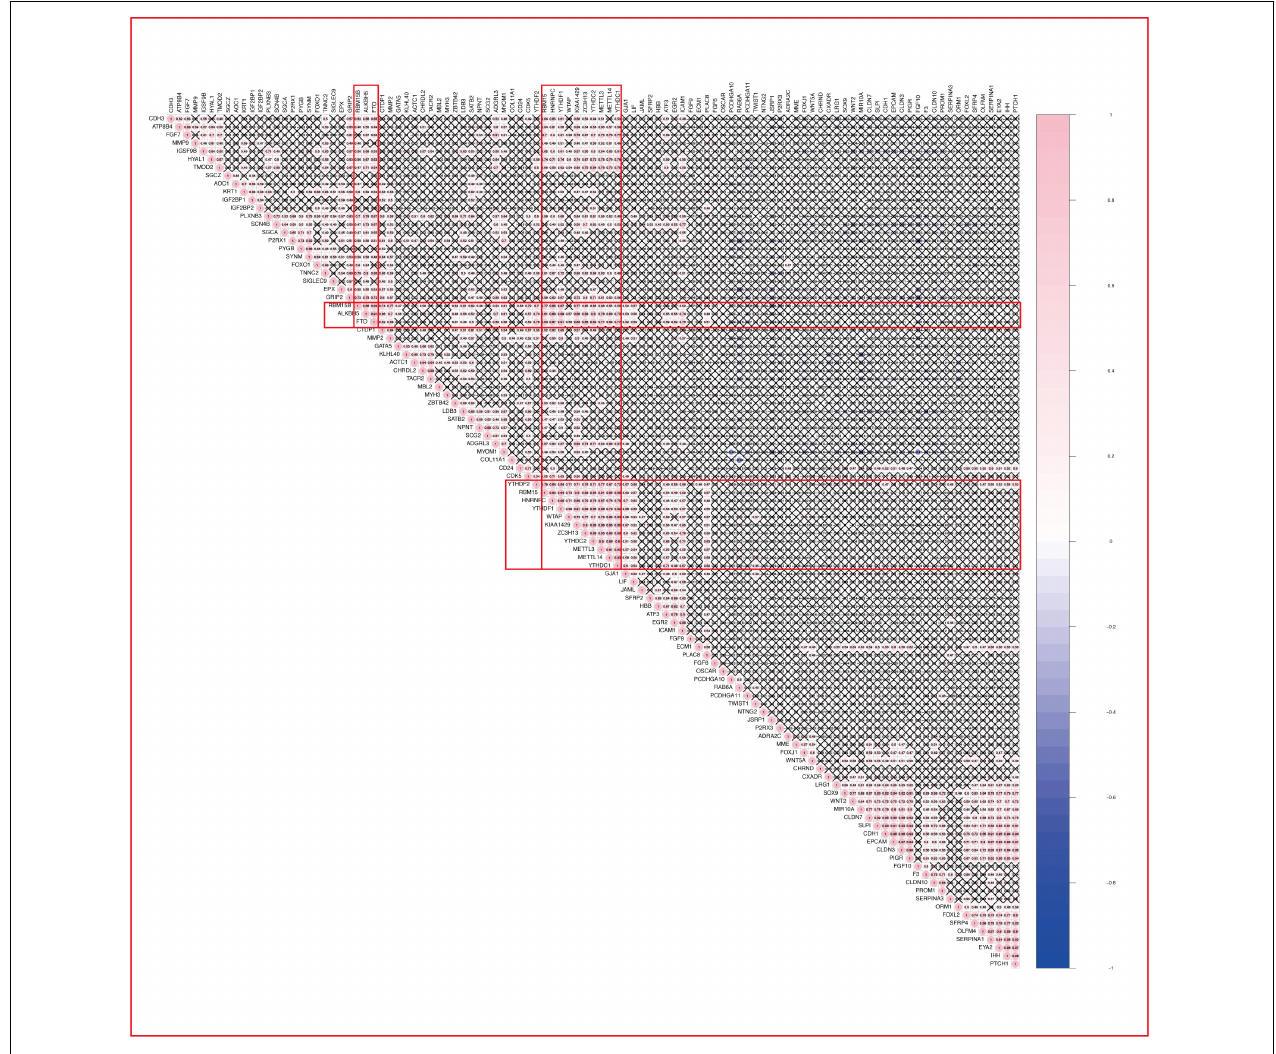
FIGURE 6 | The Spearman correlation between m 6 A RNA methylation regulators and the DEGs of myometrium enriched in the GO terms that related to myometrium dysfunction of adenomyosis patients. “X” p > 0.001, Red line clarified that correlation between the 13 m 6 A regulation “cluster” and other